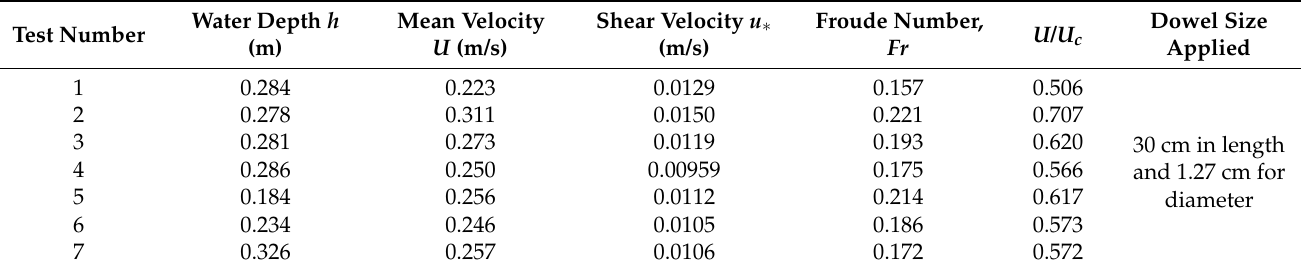
Table 1. Experiment matrix.